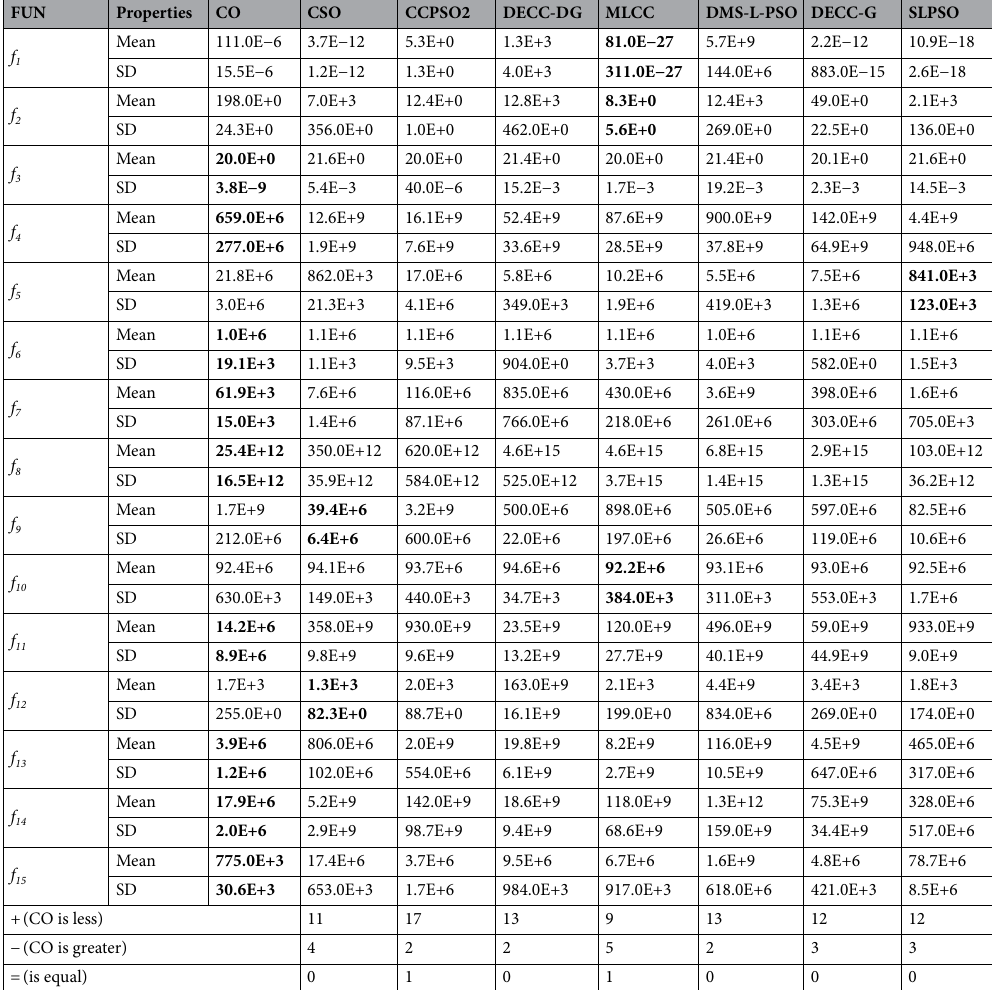
Table 8. Comparison of results of CO and state-of-the-art methods on the CEC2013 large-scale functions. Significant values are in [bold].